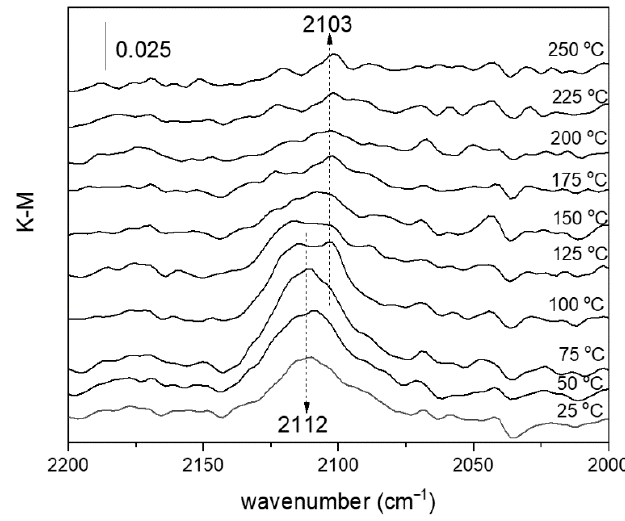
Figure 7. DRIFTS spectra under CO-PROX conditions for 1Cu/CoFe at indicated temperatures.